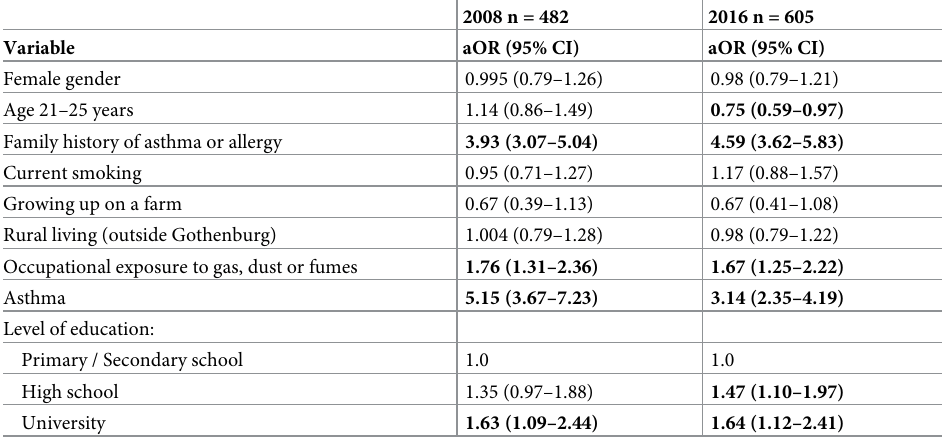
Table 3. Independent risk factors for current allergic rhinitis in 2008 and 2016.